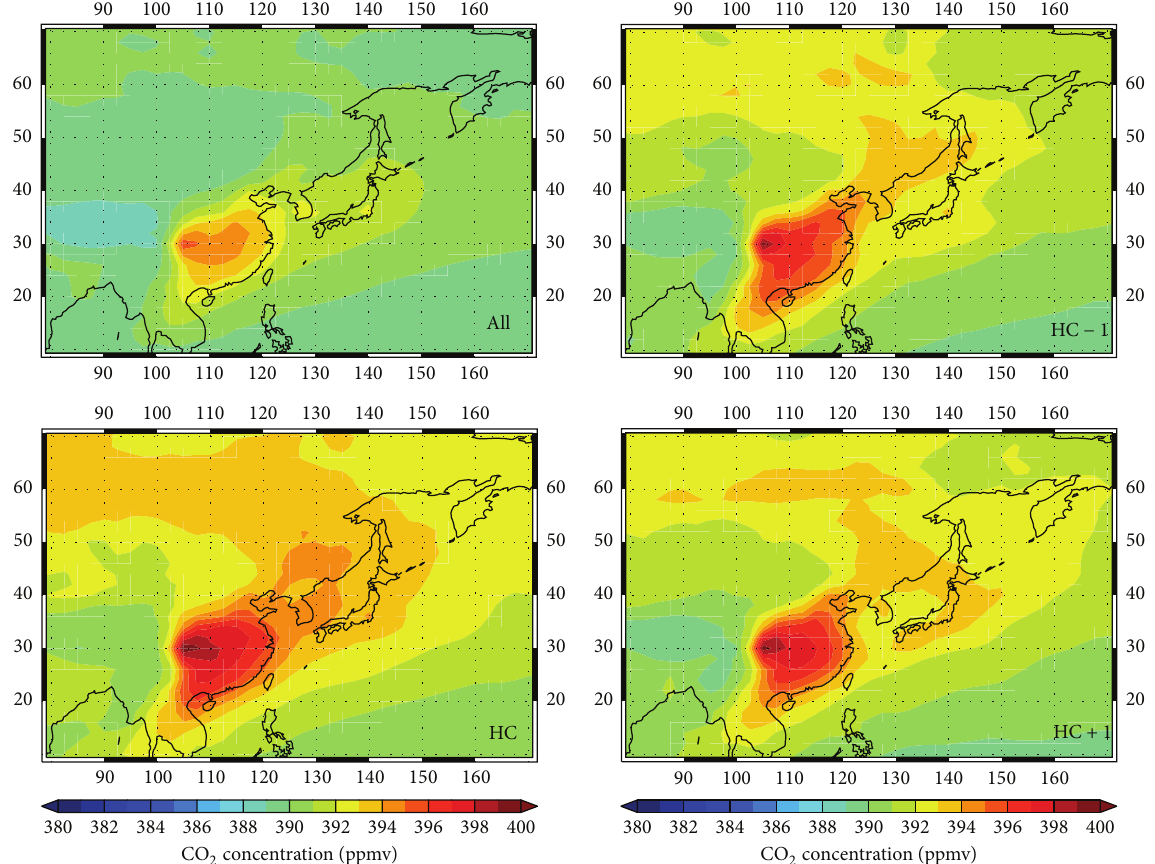
Figure 8: Distribution of the column-averaged CO 2 concentrations for all periods (All) and high concentration cases (HC − 1, HC, and HC + 1) simulated by